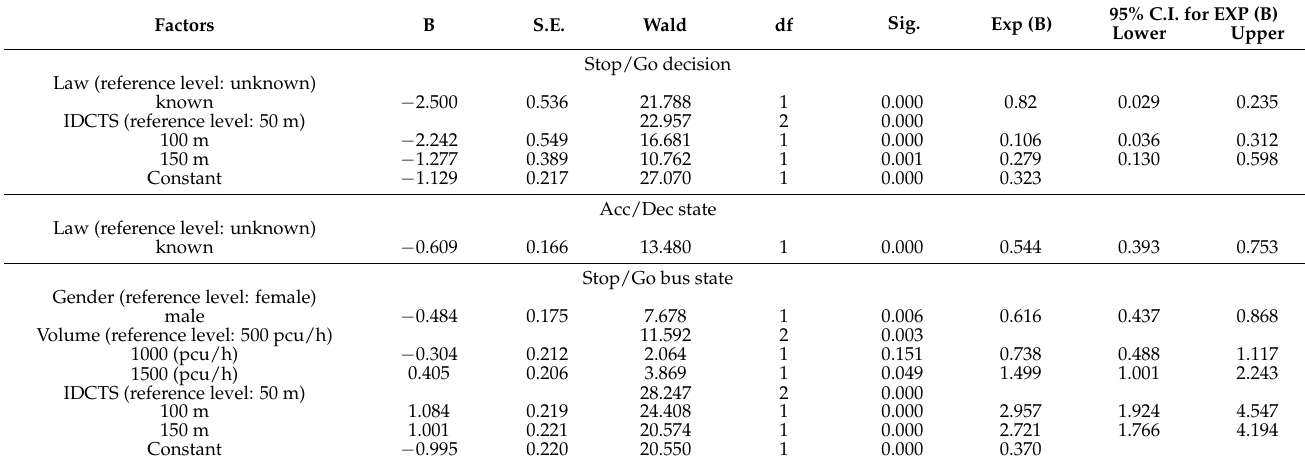
Table 3. Results of logistic regression model for Stop/Go decision, Acc/Dec state, and Stop/Go bus state.